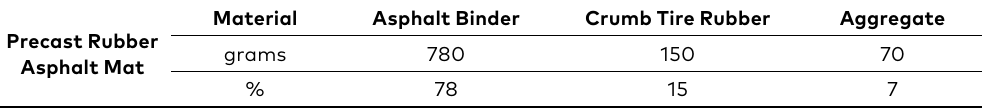
Table 2. Job mix formula of Precast Rubber Asphalt Mat